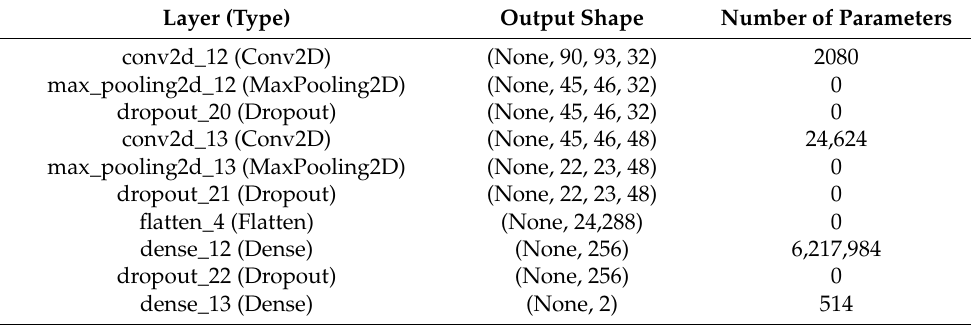
Table 3. The first model of the network used in Experiment 7.